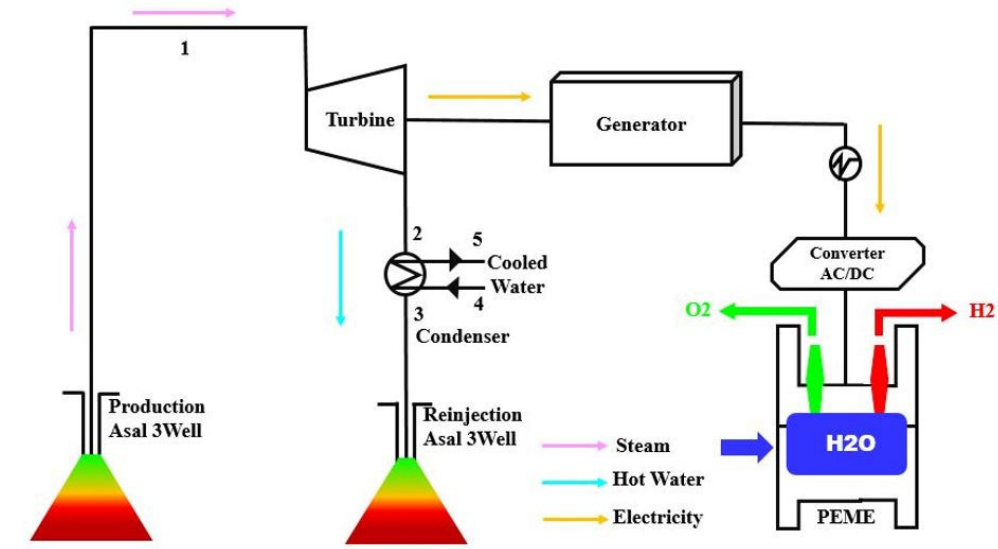
Figure 4. Schematic of the dry steam cycle with electrolyzer for Asal-Ghoubbet hydrogen production.